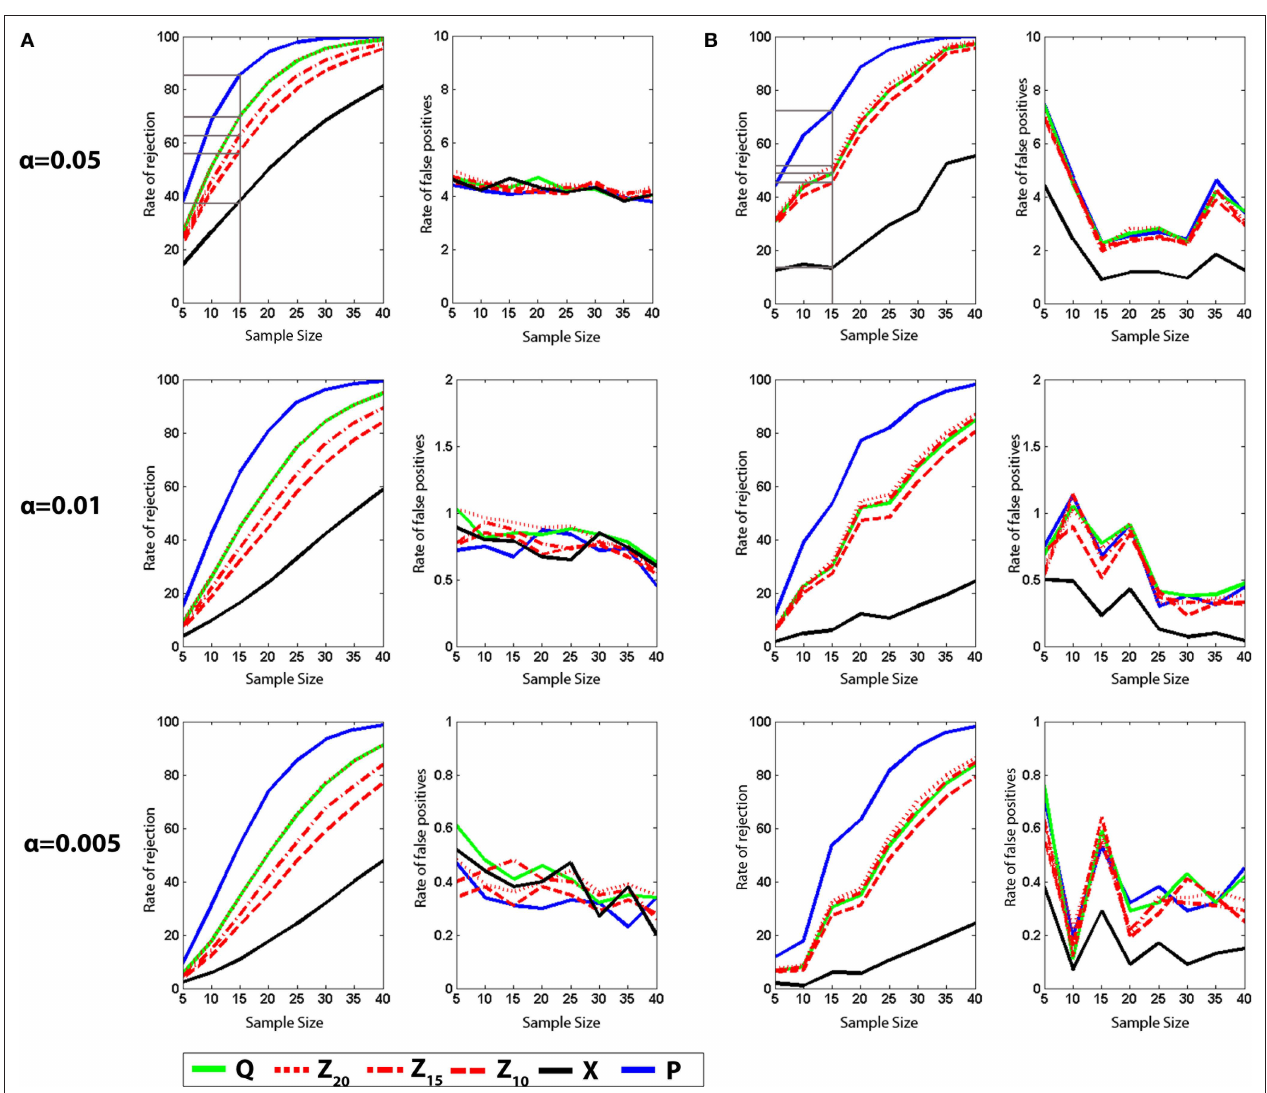
(B) K–S tests. Left, the likelihood of detecting a difference between control and experimental groups is shown for varying sample ( N ) size, with signifi cance levels α = 0.05, 0.01 and 0.005. Right, false-positive rate when both samples are drawn from the control dataset. Q (green), Z (red; Z , Z and Z ), X (black) and P 20 15 10